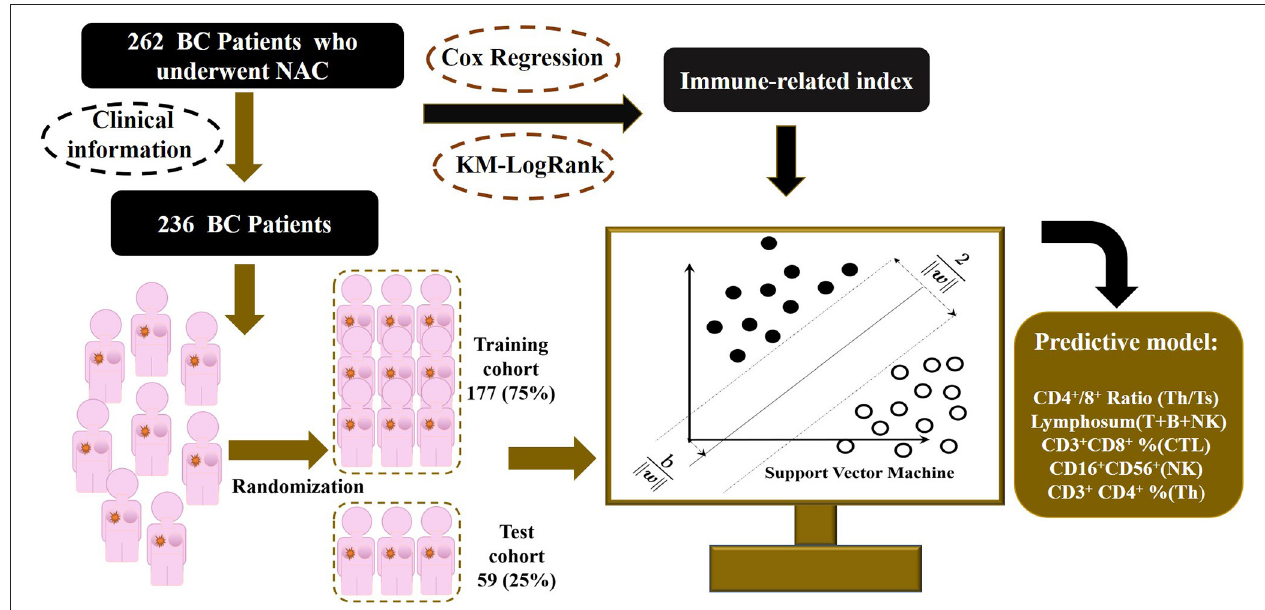
FIGURE 1 | Outline of the SVM-NATIM model flow. The study enrolled 262 women with breast cancer, collecting immune function indexes before and after neoadjuvant chemotherapy. After data processing, 236 patients were put into modeling procedure. Univariate analysis and supporting vector machine were performed to select independent indicators and train a predictive model, named as NeoAdjuvant Therapy Immune Model